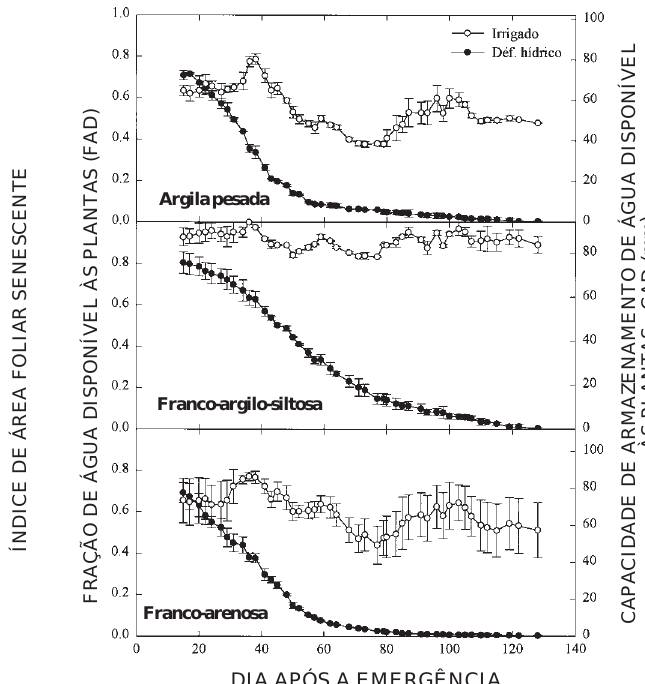
Figura 1. Índice de área foliar e senescência das plantas de milho submetidas a déficit hídrico terminal e irrigadas em solos de diferentes texturas. As barras verticais representam o desvio-padrão.